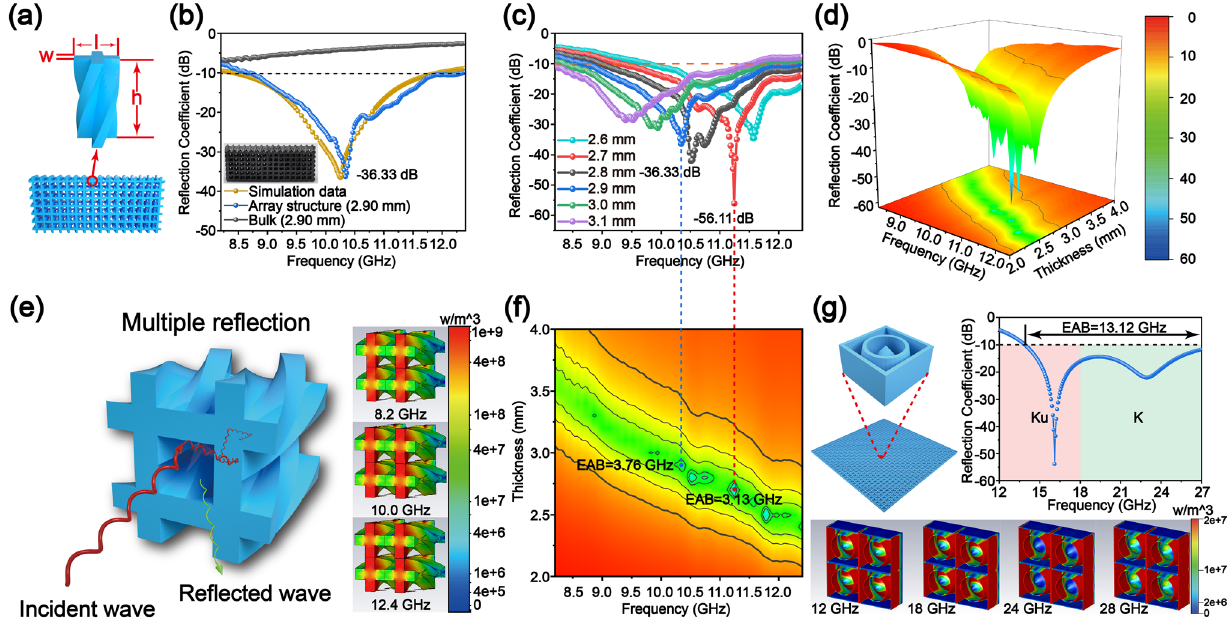
Fig. 4 Design and fabrication of Si–O–C ceramic metamaterial structure in X-band: a unit and array structure models; b calculated RC values of the bulk sample, array structure sample, and the simulated data of the array structure; c RC versus frequency and thickness corresponding to d 3D graph and f 2D projection diagram; e multiple reflection mechanism; and g metamaterials structure design suitable for Ku and K